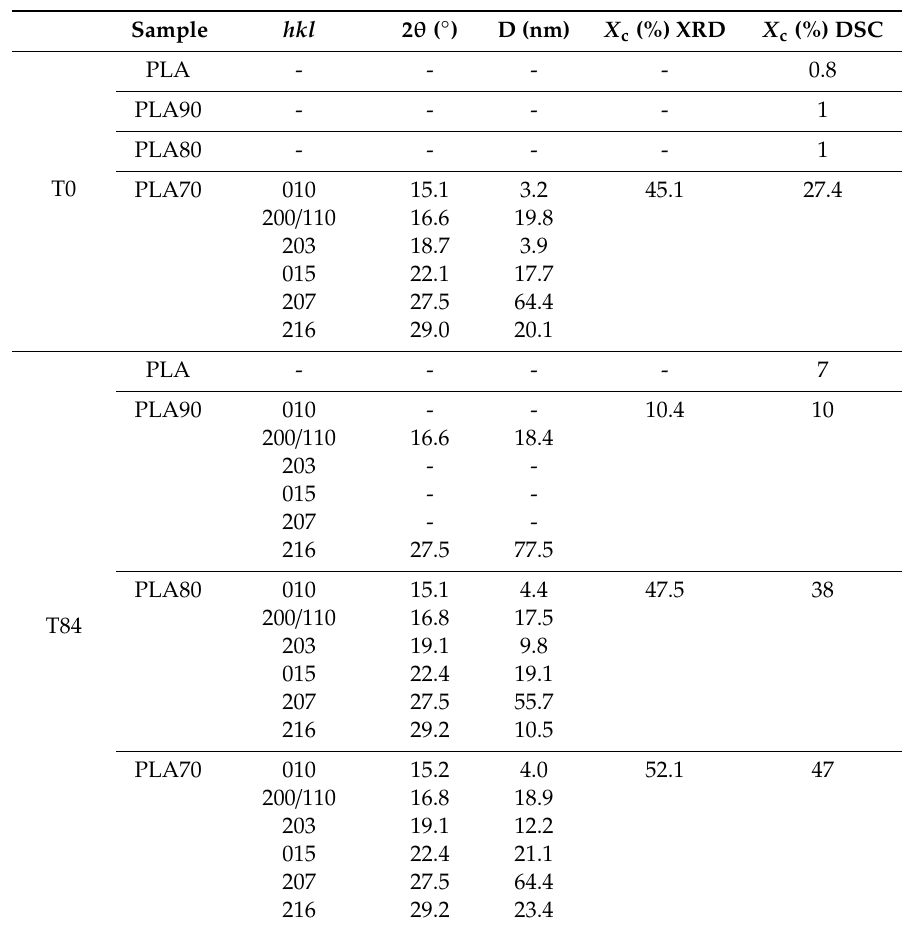
Table 4. Results of XRD analysis for neat PLA and each of the PLA:OLA electrospun samples for T0 and